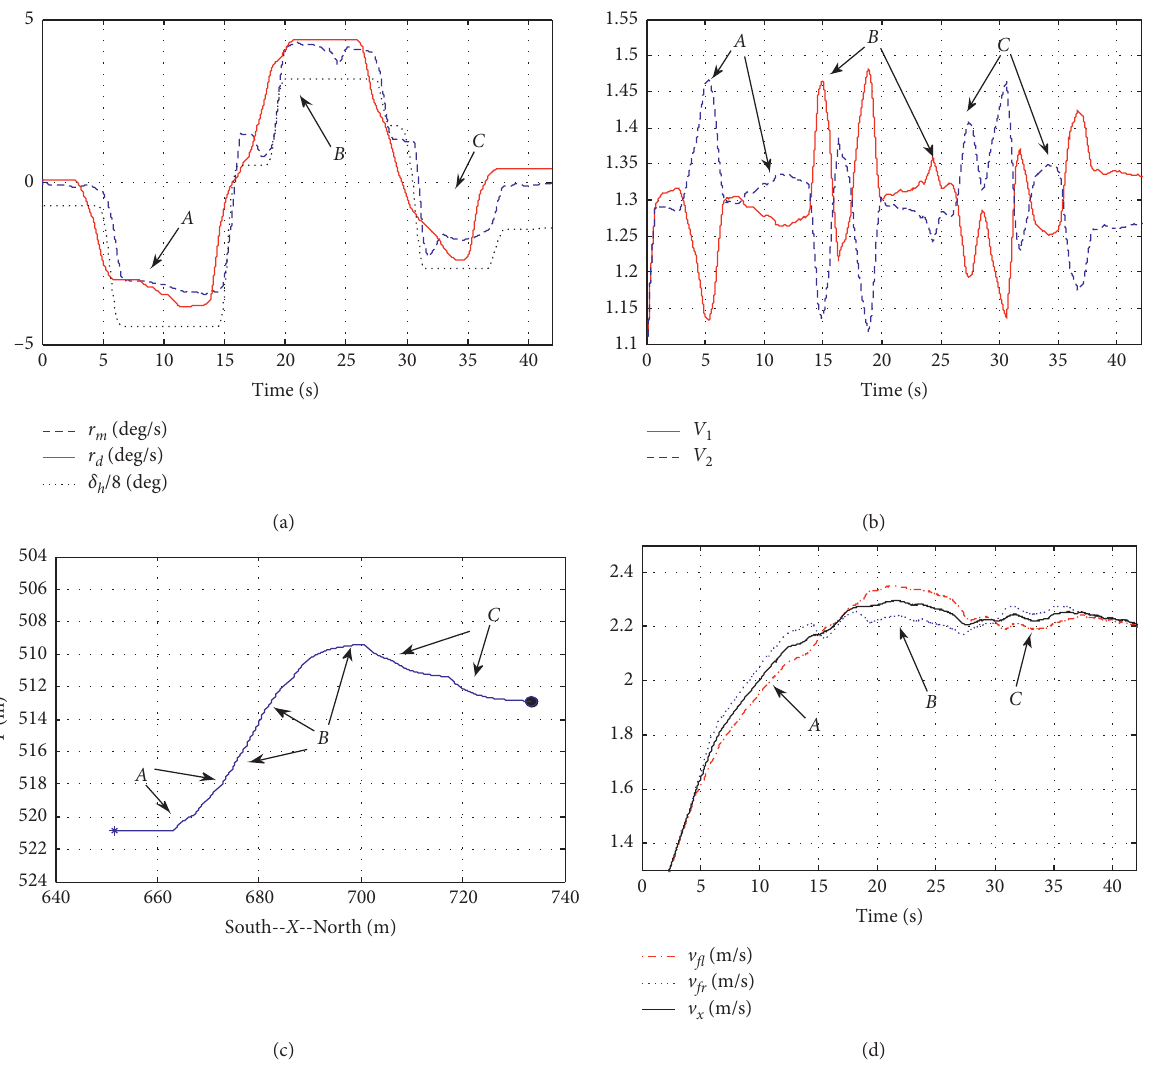
Figure 8: Yaw rate tracking with lane-change-like maneuver. (a) Time (s). (b) Time (s). (c) South- X -North. (d) Time ( v fr ) than the left ( v fl ) as in zone A of Figure 8(d). The actual yaw rate tracks the desired value well in zone A . In zone B of